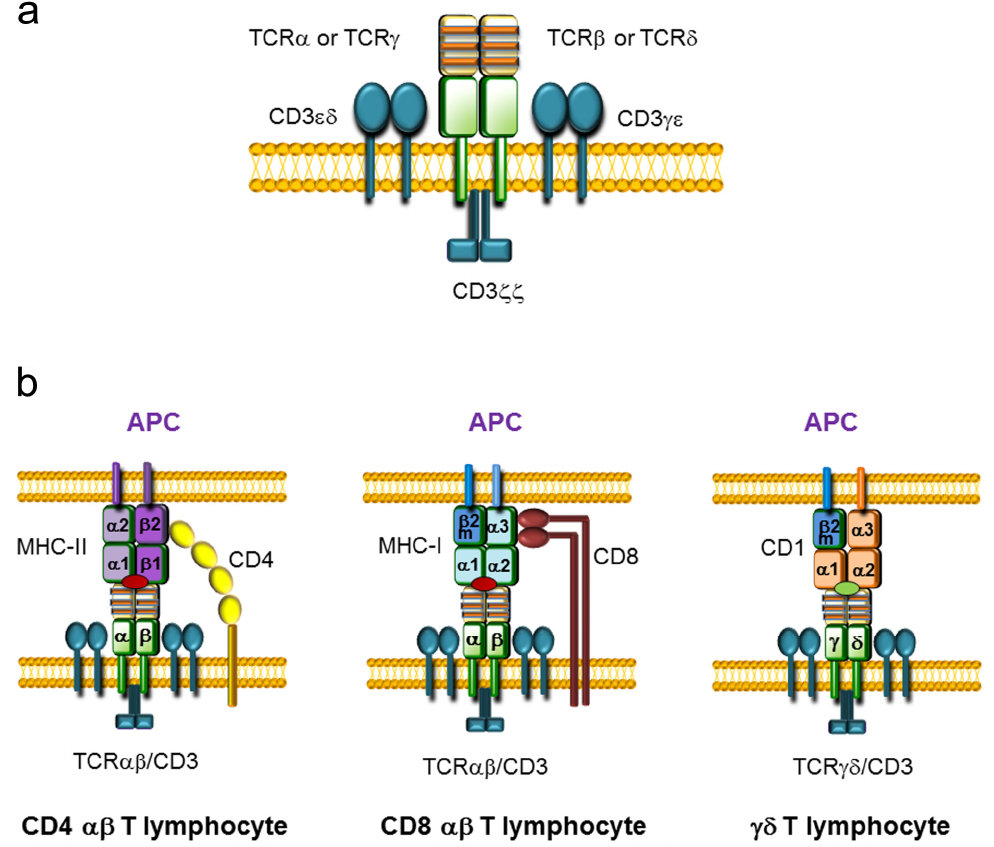
Figure 1. T-cell receptor (TCR) structure and TCR-antigen presenting cell (APC) interaction. ( a ) Representation of TCR αβ and TCR γδ complexes assembled with CD3 complexes on the cell membrane. TCR αβ and TCR γδ consist of two variable chains (TCR α and TCR β or TCR γ and TCR δ , respectively) covalently bound by disulfide bridges that are associated with three CD3 dimers (CD3 εδ , CD3 γε , and CD3 ζζ ). The variable regions of the TCR chains are represented in yellow, whereas the constant (C) regions are represented in green. The three complementary determinant regions (CDRs) present within the variable regions are represented by orange stripes. The CD3 dimers are represented in blue. ( b ) Representation of the interactions between the TCR on T lymphocytes and antigen-presenting molecules on APCs. TCR αβ /CD8 or TCR αβ /CD4 present on αβ T lymphocytes and the major histocompatibility complex (MHC) loaded with a peptide (red oval) expressed on APCs are illustrated. The CD4 coreceptor is represented in yellow and the CD8 coreceptor is represented in brown. MHC molecules consist of heterodimers: MHC class I (MHC-I) is formed by an α chain and β 2-microglobulin ( β 2m), and MHC class II (MHC-II) is formed by an α chain and a β chain. CD4 αβ T lymphocytes interact with the β 2 domain of the MHC-II β chain, whereas CD8 αβ T lymphocytes interact with the α 3 domain of the MHC-I α chain. The interaction between the TCR γδ and a CD1 molecule, consisting of an α chain and β 2m, loaded with a lipid antigen (green oval) expressed on an APC is also represented.